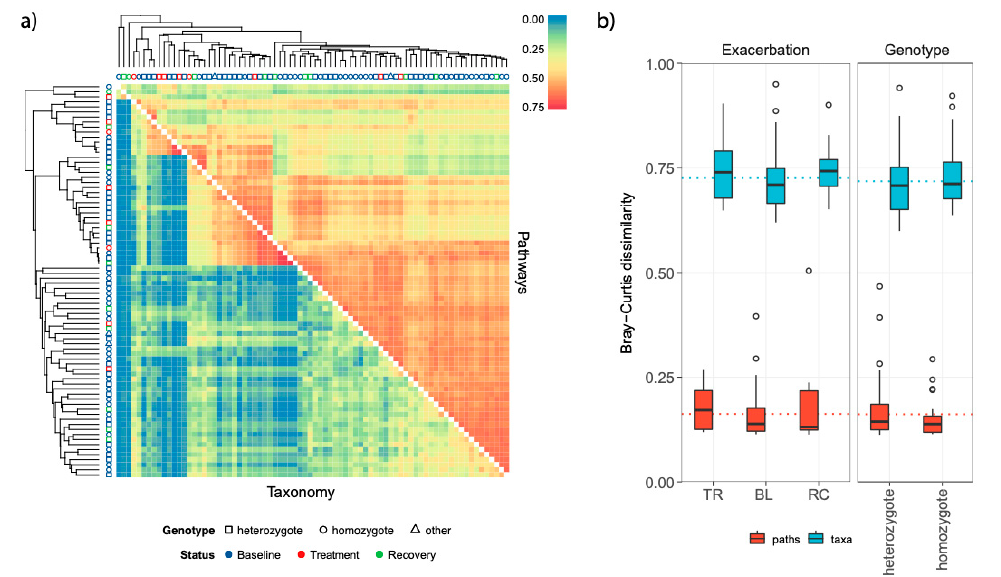
Figure 4. Beta diversity analysis on both taxonomic and functional distribution. ( a ) Hierarchical clustering based on UPGMA method. Clustering was performed on both pathway distribution (the upper triangle) and taxonomic composition of samples (lower triangle). The Bray-Curtis distance was used to compute distances between samples, but it was transformed into similarity value by subtracting 1 before plotting. Thus, red colors represent high similarity values whereas blue colors represent low similarity values. The shape of the points on each tip of trees refers to the genotype whereas the colors refer to the exacerbation events. ( b ) Results of Tukey’s post hoc test on beta diversity values across patient genotypes and exacerbation events. Contrasts were computed even to test differences between taxonomic distribution and pathways with taxa reporting higher level of beta diversity. Homozygote and heterozygote refer to Δ F508 mutation of CFTR gene. BL, baseline; TR, treatment; RC, recovery. Each box shows the “interquartile range” (IQR) that is the differences between the third and the first quartile of data (the 75th and the 25th percentile). Horizontal bars are medians whereas whiskers represent the minimum and maximum values defined as Q1 – (1.5 x IQR) and Q3 + (1.5 x IQR), respectively.